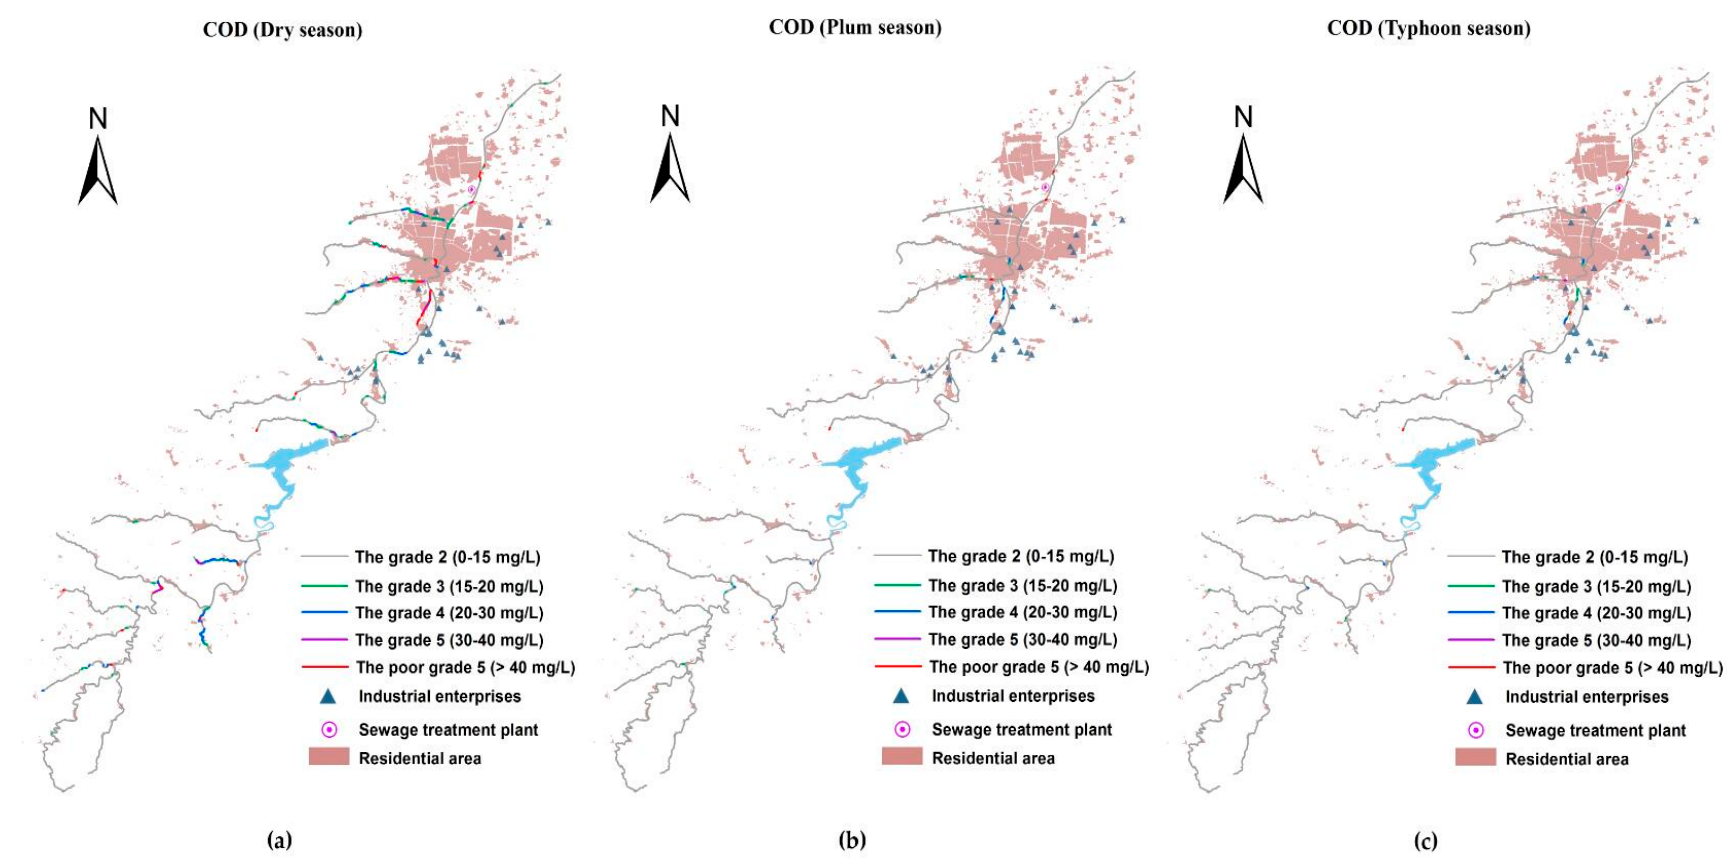
Figure 7. The space–time distribution of COD water quality standard for the Xian-Jiang Basin: ( a ) concentrations in the dry season; ( b ) concentrations in the plum rain season; and ( c ) concentrations in the typhoon season.